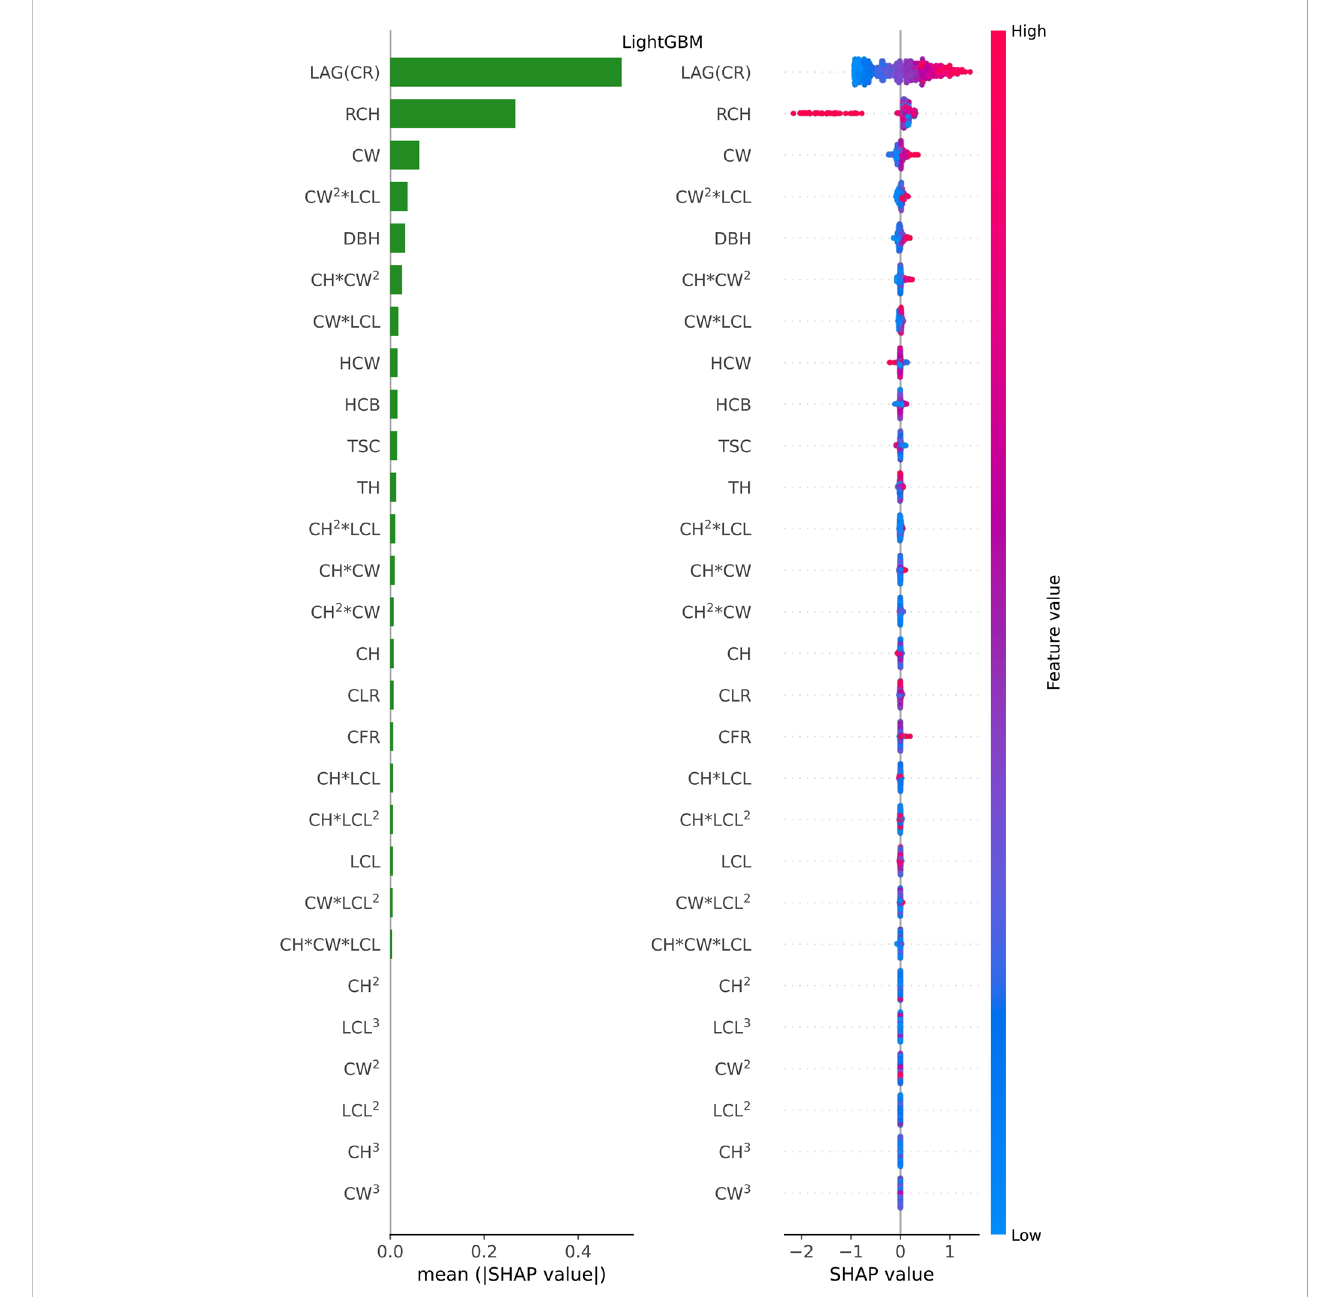
FIGURE 6 Feature importance bar plot (mean (|SHAP value|), left plot) and beeswarm plot (mean value, right plot) for LightGBM model. Where color represents characteristic value (red high, blue low). * indicates a multiplication